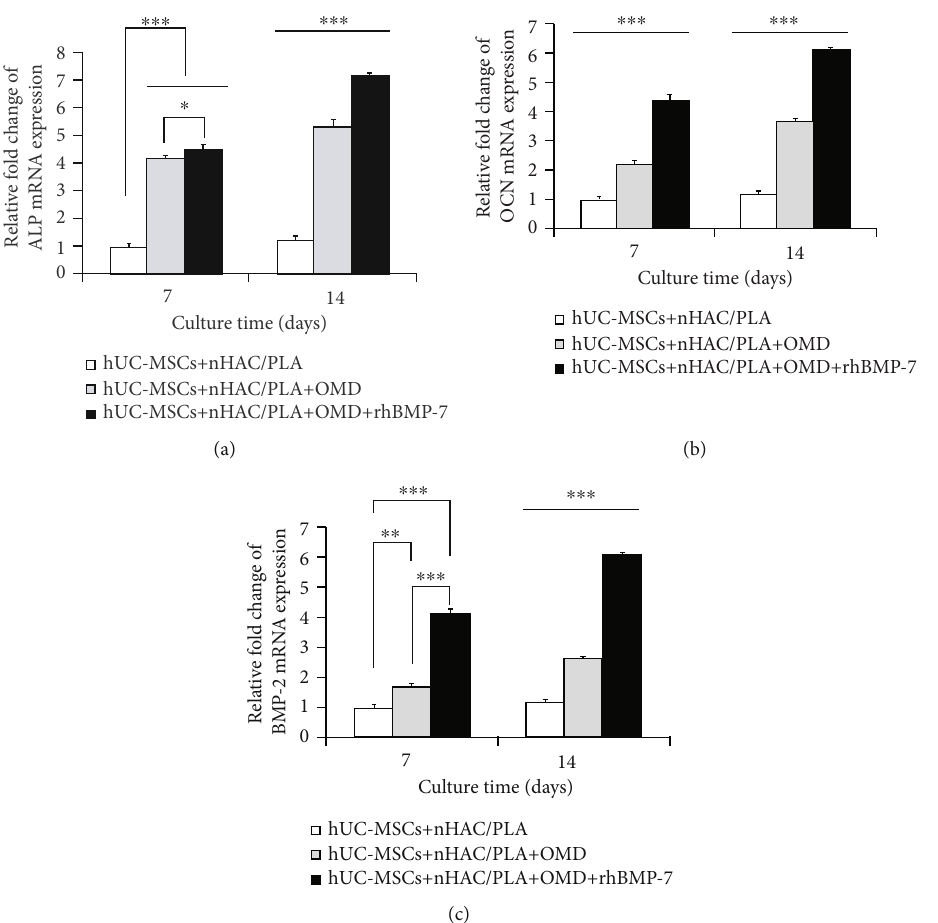
Figure 6: Gene expression related to osteogenic di ff erentiation in hUC-MSCs in the in vitro three-dimensional culture microenvironment ( mean ± SD , n = 3 ). (a) ALP. (b) OCN. (c) BMP-2. ∗ P < 0 : 05 , ∗∗ P < 0 : 01 , ∗∗∗ P < 0 : 001